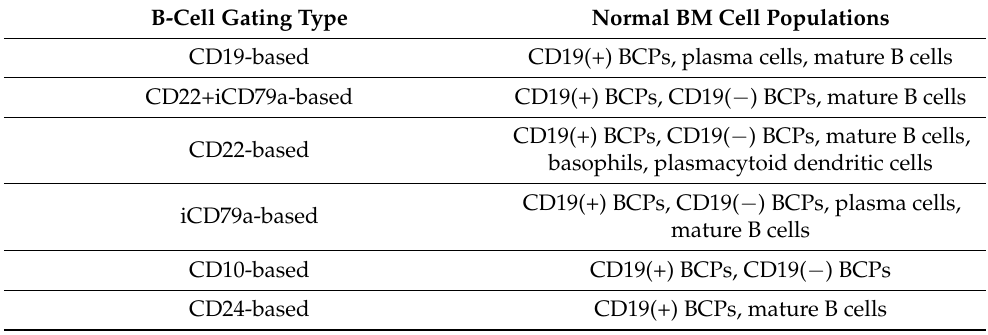
Table 2. Number of normal cell populations in the B-cell gate according to the gating strategy.